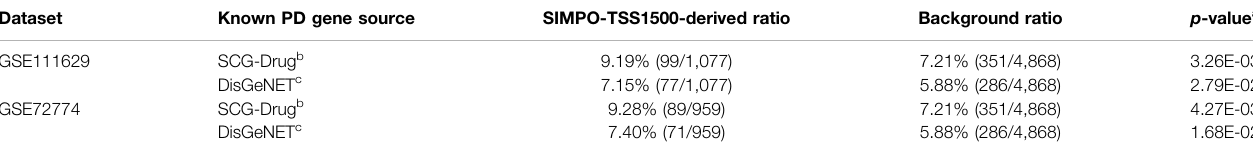
TABLE 5 | The known PD-associated gene enrichment of SIMPO-TSS1500-calculated genes. Dataset